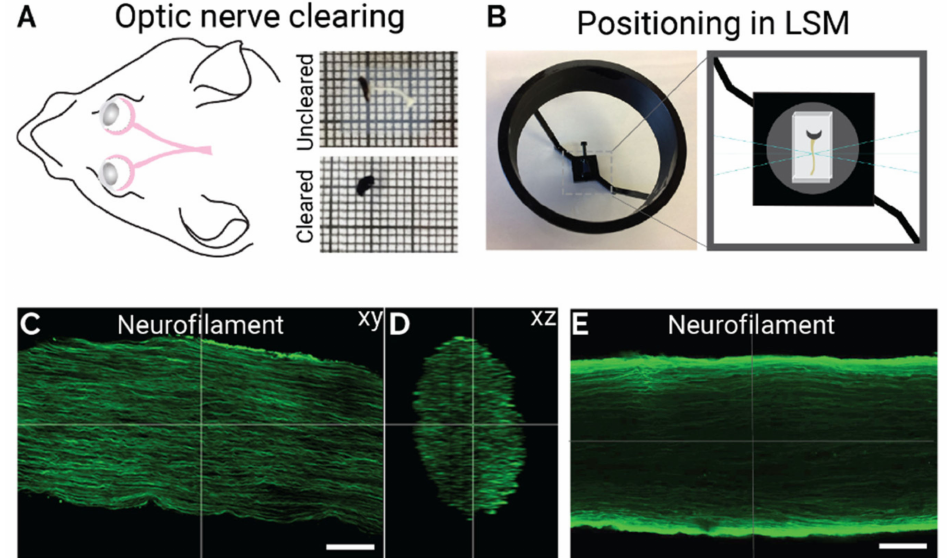
Figure 1. Optimized iDISCO for light sheet imaging of mouse optic nerve. ( A ) the optic nerve diagram is shown alongside the optic nerve before clearing (white in colour attached to the black globe of the eye) and after clearing (transparent, only globe is visible). ( B ) Positioning of the agar embedded optic nerve block in the light sheet microscope stage. ( C – E ) Representative max projection of optic nerves labelled with neurofilament, using either a single pre-conjugated antibody ( C , D ) or a separate primary and secondary antibody ( E ). Scale bar = 100 µ